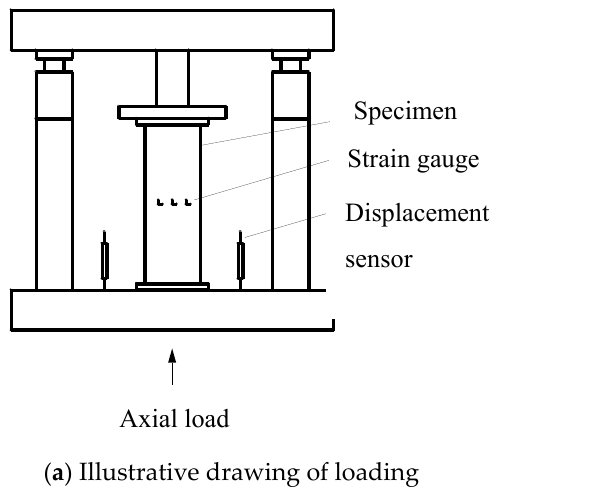
Figure 3. Fabrication process of square CFST.